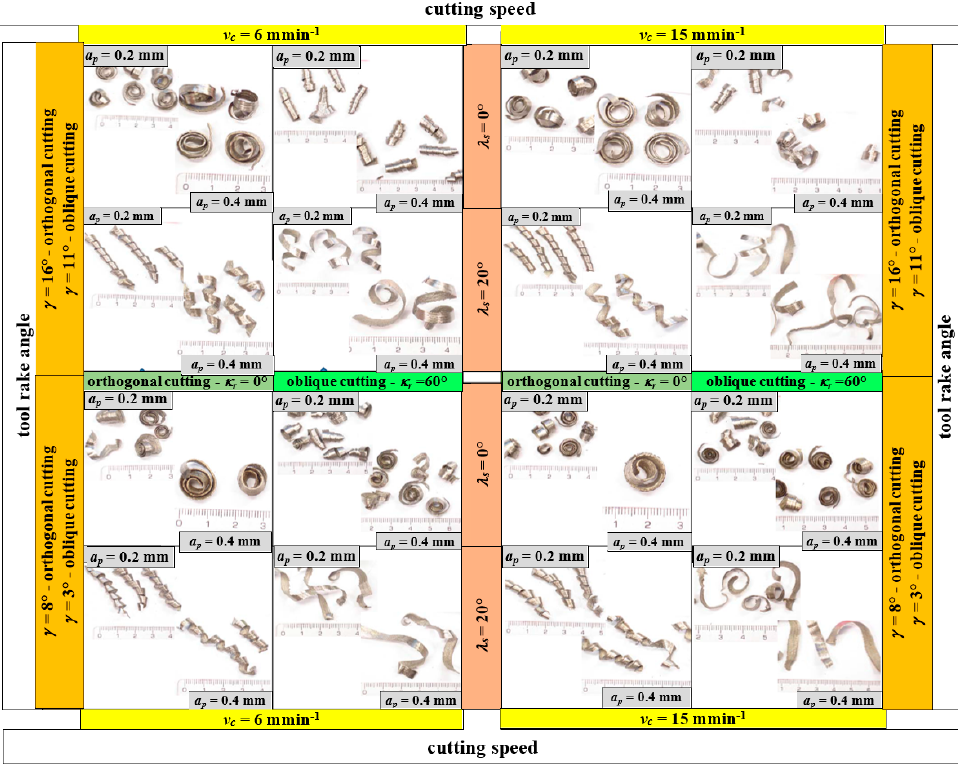
Figure 27. The shapes of chips of EN 16MnCr5 steel and their dependence on cutting parameters.